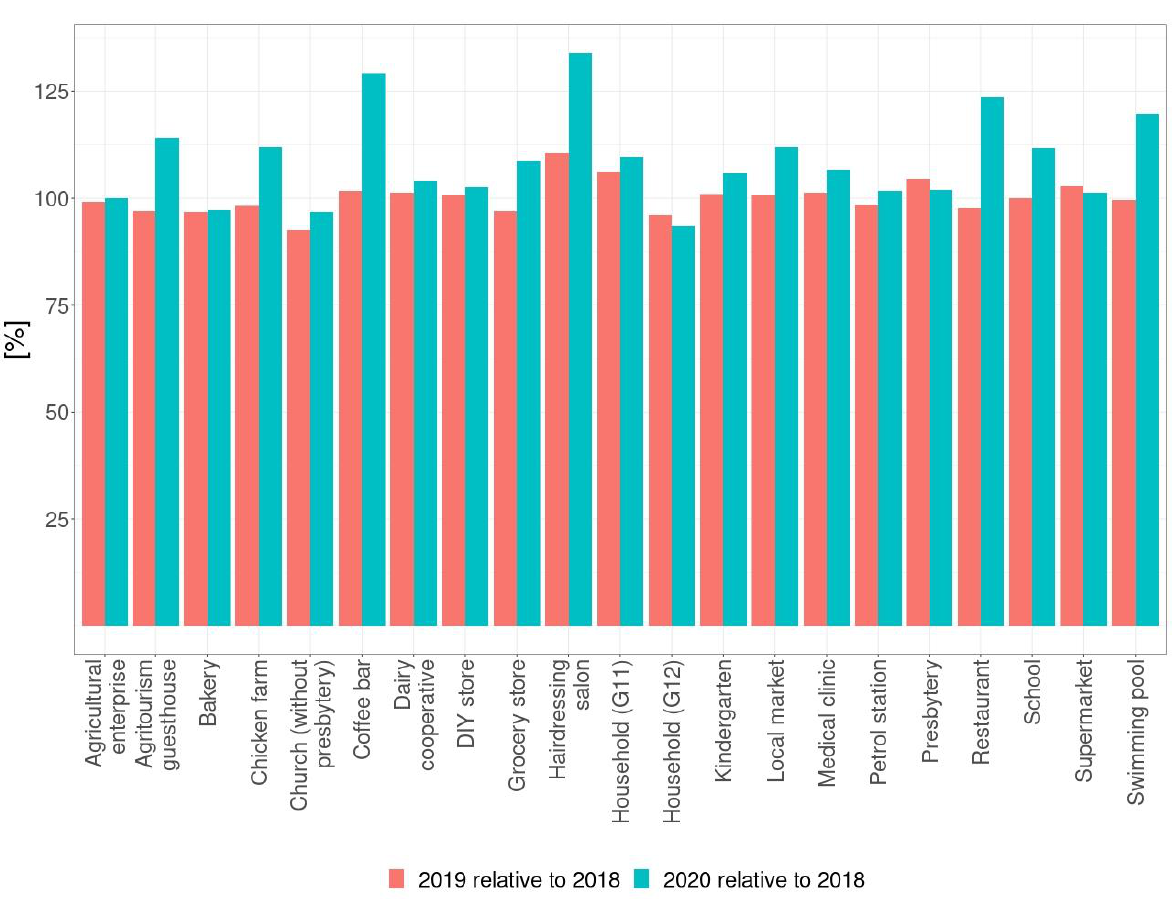
Figure 5. Dynamics of electricity exchange with the network broken down by prosumers and various analysis periods.